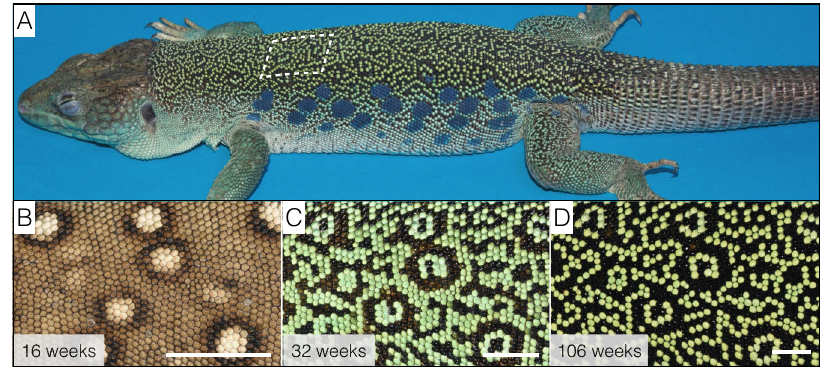
Fig. 1 Colour pattern ontogeny in ocellated lizards. A Adult ocellated lizards (here, a 3-year-old male) exhibit a labyrinthine dorsal pattern made of contrasting black and green chains of scales; we ignore here the lateral blue ocelli and the ventral scales. B – D Dorsal pattern time evolution from the juvenile brown skin with white ocelli to the nearly adult pattern. Note that remnants of the initial pattern organisation (mostly the position of white ocelli) are somewhat visible at the age of 106 weeks ( D ) but get obliterated in older lizards. Scale bars: